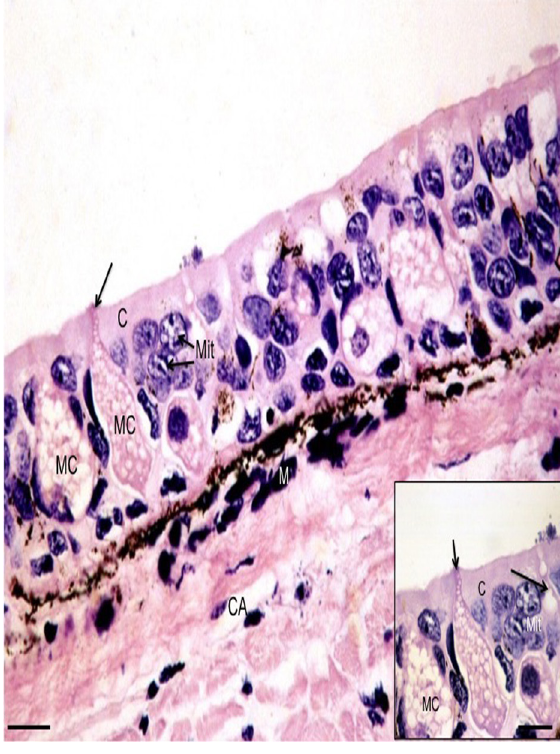
Figure 3 - Skin of dorsocephalic region of L. paradoxa . epidermis with abundant mucus-secreting (MC) cells. The mucus is released at the surface, forming the cuticle (C). Several mitotic (Mit) cells are visible. In the dermis, melanophores (M) and capillaries (CA) are visible. H-e. Bar: 50 μm. Insert: mucus-secreting (MC) cells releasing mucus to the outside (short arrow), forming the cuticle (C). There is a tubule of an electroreceptor (long arrow), and mitosis (Mit) can be observed. H-e. Bar: 20